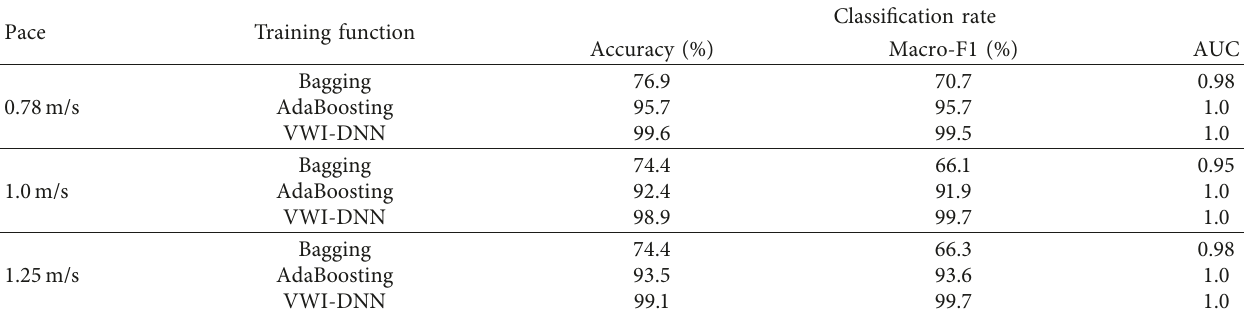
Table 6: Summary of classification performance for different training